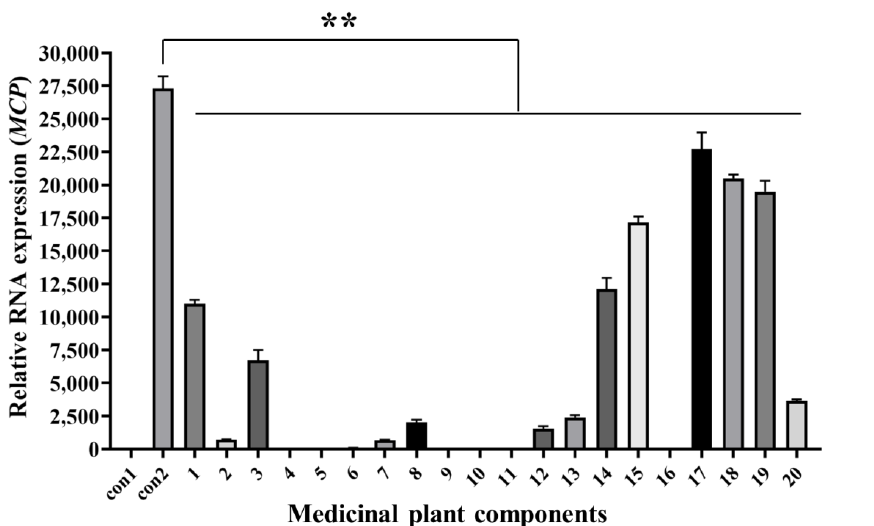
7 of 12 Figure 4 . Antiviral analysis of 20 medical plant components against SGIV infection. AHTS results showed that fluorescence of target cells incubated with both SGIV and all components (Nos. 1 – 20) decreased obviously. Results are presented as mean ± SD of three independent experiments (** p < 0.01). 3.5. Antiviral Activity Analysis of Medicinal Plants Components with RT-qPCR The cells and culture supernatants at 48 hpi were collected for RT-qPCR analysis.